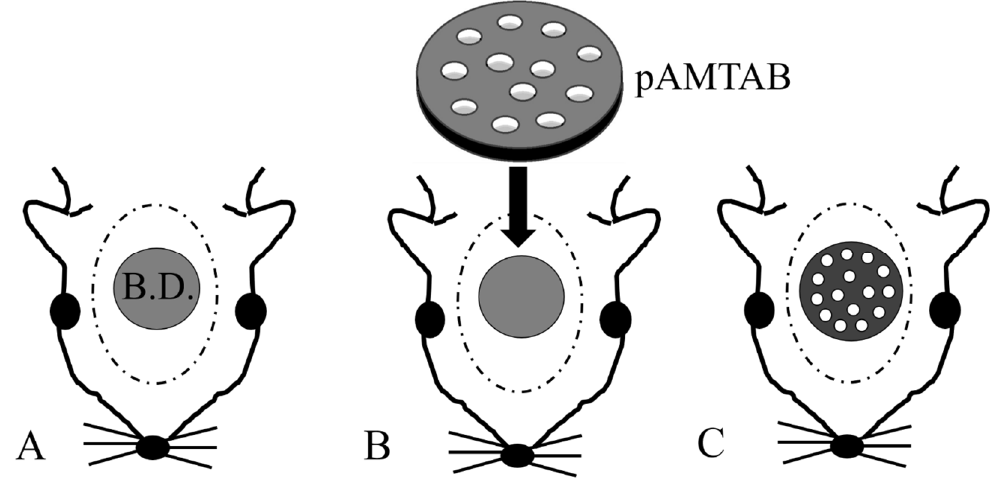
Figure 2. Photograph of implant placement. ( A ) A defect is created in a rat calvarial bone using a trephine bar (5 mm diameter). B.D.: bone defect. ( B ) The pAMTAB is inserted into the defect. ( C ) The pAMTAB is rigidly implanted in the bone defect.